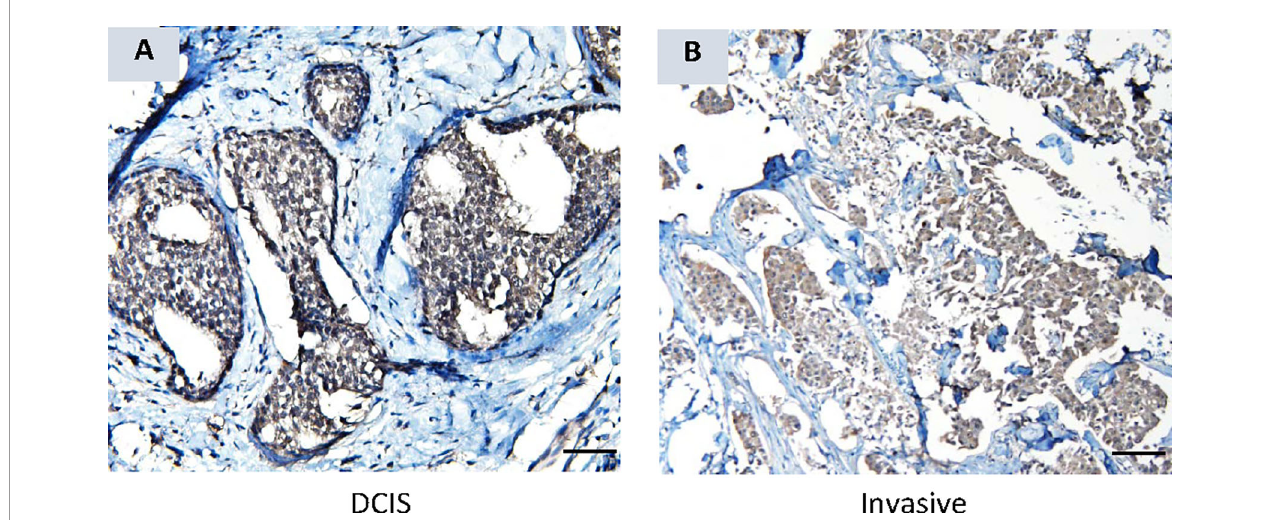
FIGURE 6 | AKR1B10 expression by immunohistochemistry in ductal carcinoma in situ (DCIS). (A) AKR1B10 expression in DCIS, and (B) AKR1B10 expression in invasive cancer for a comparison.